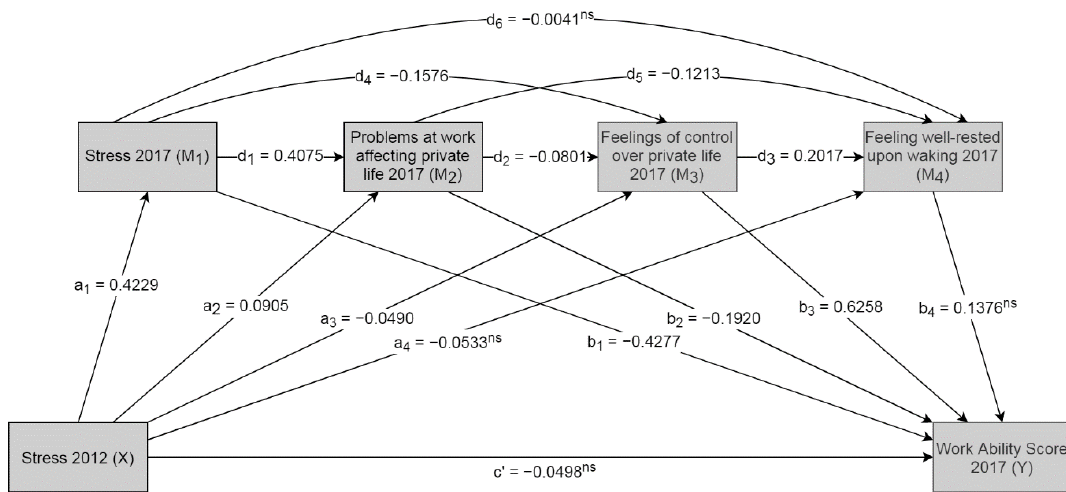
Figure E1: Quadruple mediation with individual effect per path for males. (All paths are significant Figure A5. Quadruple mediation with individual e ff ect per path for males. (All paths are significant p < 0.05, except a 4 , b 4 , d 6 , and c (cid:48) p < 0.05, except a 4 , b 4 , d 6 , and c’)